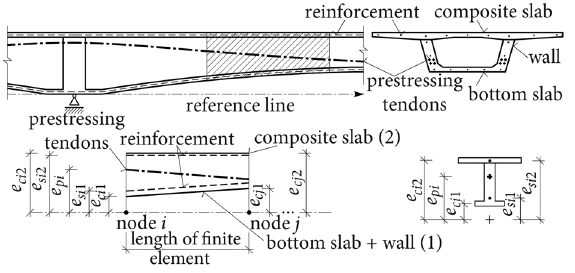
Fig. 3. TDA finite element